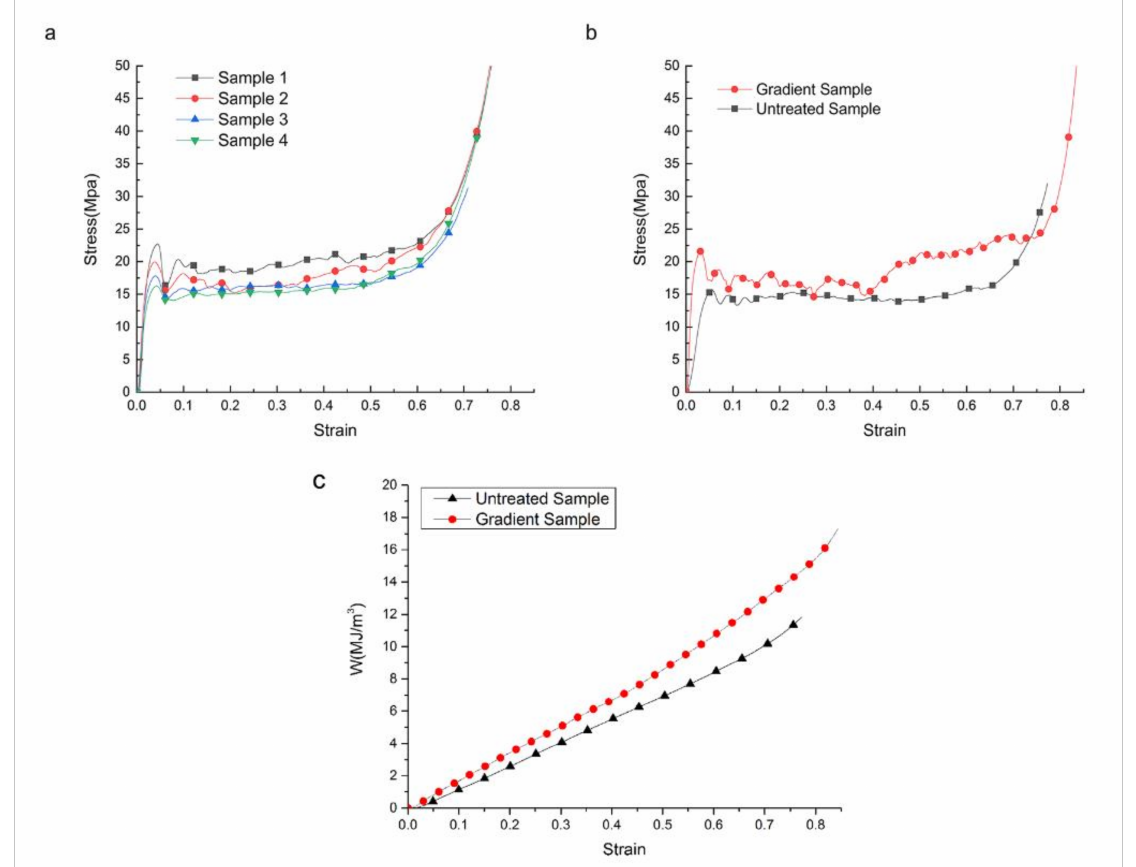
Figure 3. ( a ) Stress–strain curves at different locations ( b ) Stress–strain curves of gradient samples and untreated samples ( c ) Energy absorption curves of gradient samples and untreated